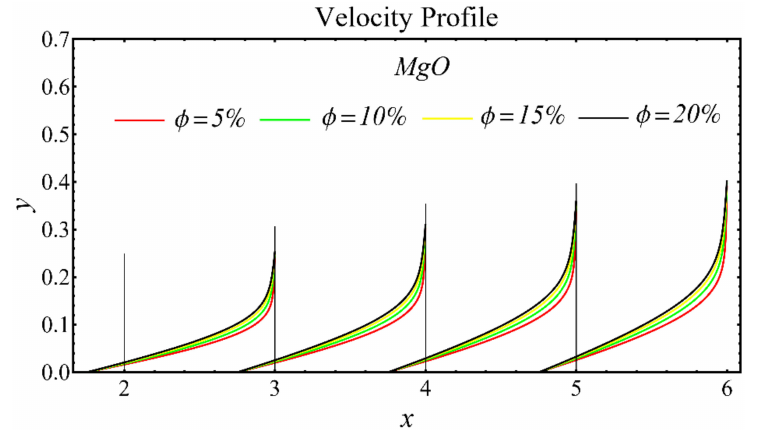
Figure 8. Velocity profile of MgO-EG nanofluid under influence of nanoparticle concentration.